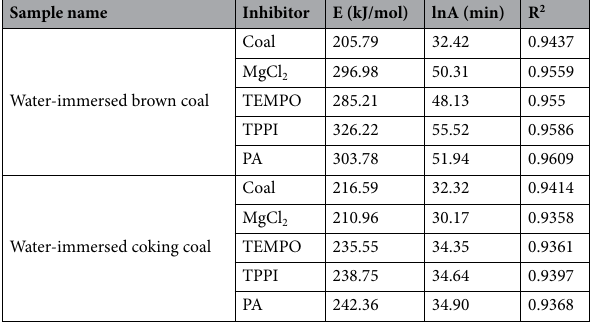
Table 7. Fitting parameters of oxidation kinetics of water-immersed brown coal and water-immersed coking coal after adding